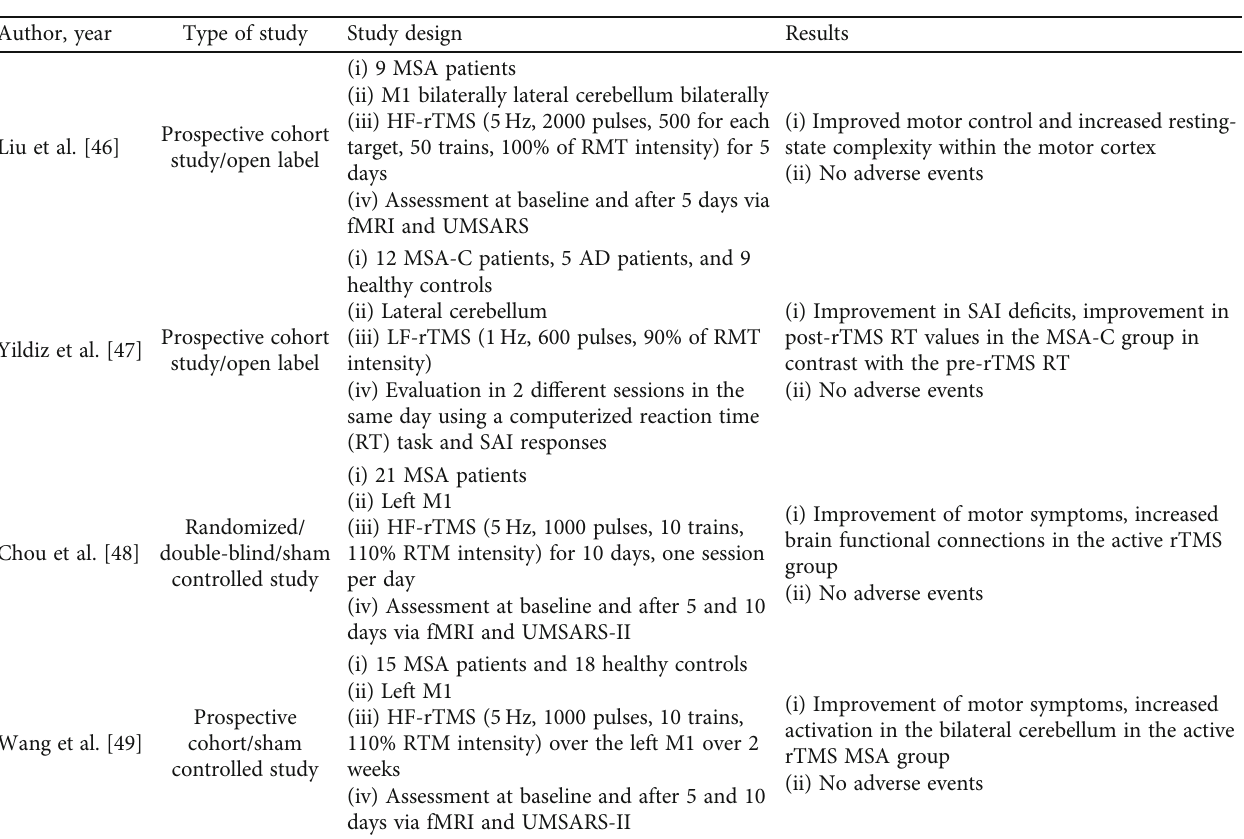
Table 2: Studies assessing rTMS in